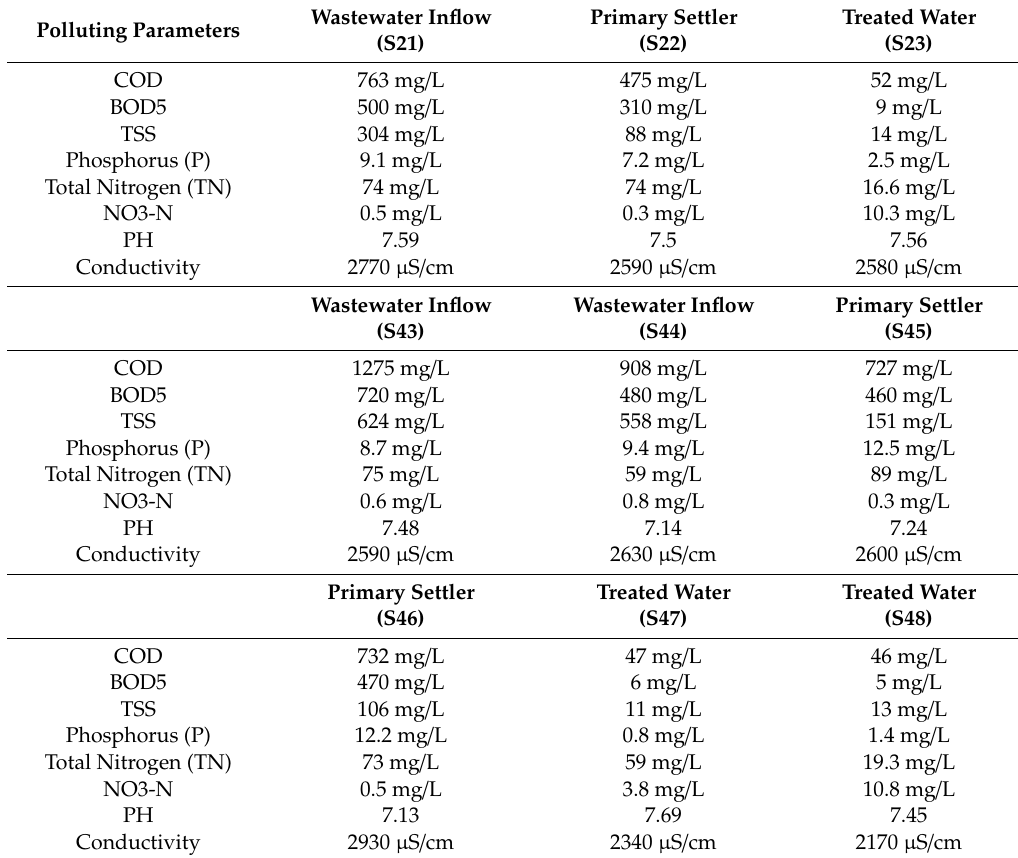
Table 2. Characteristics of wastewater shown in Figure